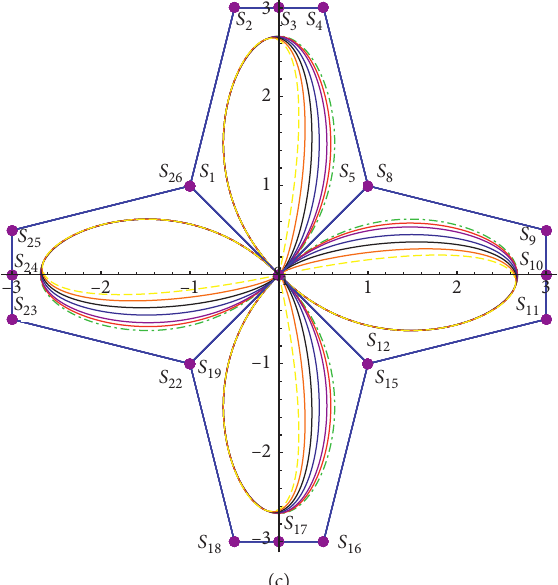
Figure 11: Construction of some closed curves by different values of shape parameters. (a) μ � ω � 1 , 0 . 5 , 0 , − 1 , − 2 , − 3 , − 4. (b) ω